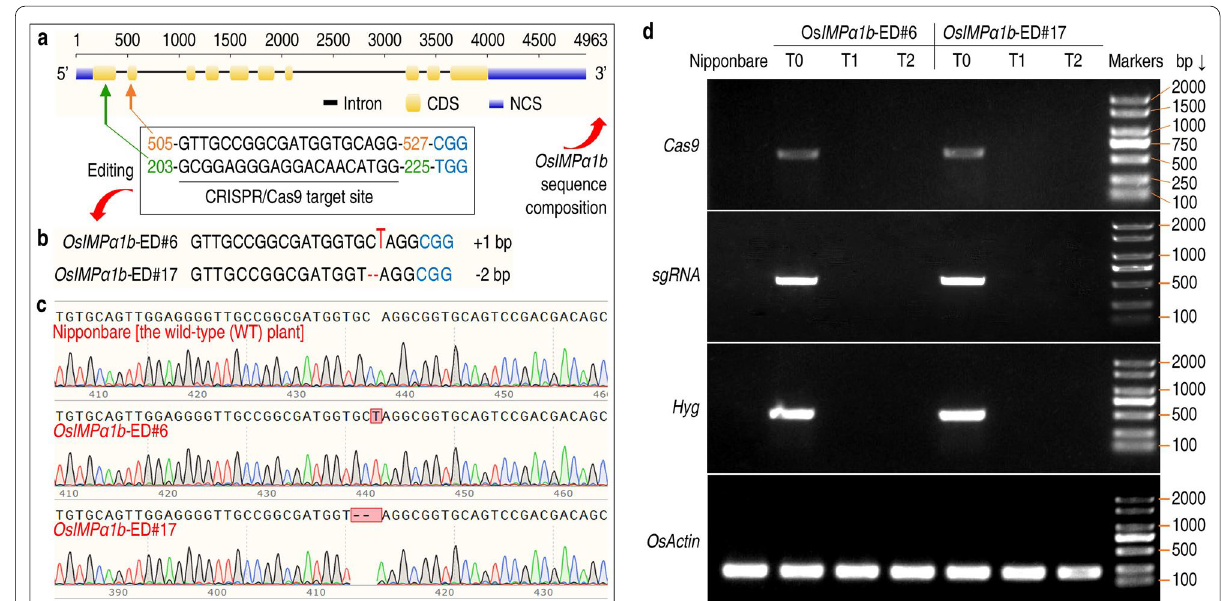
Fig. 2 CRISPR/Cas9-based OsIMPα1b gene editing and removal of transgenes by genetic segregation. a OsIMPα1b structural features along with the Cas9-targeting sites based on the T-DNA construction of an sgRNA motif linked to the Cas9-recognizable PAM consisting of NGG (CGG here). b Nucleotide changes in the targeting sequences of the OsIMPα1b -edited ( OsIMPα1b- ED) T0 lines OsIMPα1b- ED#6 and OsIMPα1b- ED#17, both of which were further investigated. c Partial fragment sequences of OsIMPα1b in WT plants (rice variety Nipponbare) and T1 progenies of the OsIMPα1b- ED#6 and OsIMPα1b- ED#17 mutants. d Genetic segregation in which the transgenes were removed during the generation of T1 and T2 progenies of both mutants tested in comparison with the WT plants. The transgenes were analyzed via PCR using genomic DNA extracted from the corresponding plant templates, and the housekeeping gene OsActin was used as a reference. Each electrophoretic agarose image is representative of 3 experimental